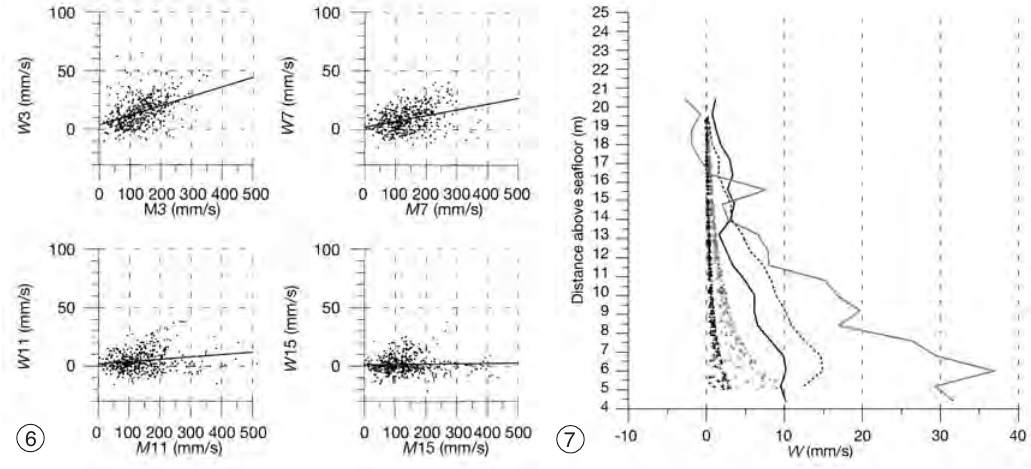
Fig. 6. Relationships and linear regression lines between W and the current speed M (in mm/s) for cells #3, 7, 11 and 15 ( i.e. at 6, 9.2, 12.4 and 15.6 m above the bottom). Fig. 7. Simulated W s ( + ) for mean currents of 100 (black) and 300 (red) mm/s parallel to a diagonal are those obtained in a prism centred on the observatory and having a 4-m side at ∼ 20 m asf. To get a sufficient number of measured W s to compare with, we considered altogether currents towards sectors of 45° roughly aligned with the diagonals ( ∼ 45°, 135°, 225° and 315°) and in the ranges of 80-120 mm/s (solid black) and 250-350 mm/s (solid red). Since measured values are much more scattered than simulated ones, we just reported the corresponding av- eraged profiles. The blue dashed line represents the averaged W s whatever the mean current direction and